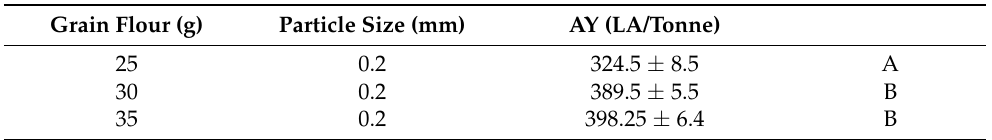
Table 5. Average alcohol yield achieved during experiments to test if there was a significant difference between using 25–35 g of grain flour. All results are the mean ± standard deviation ( n = 3). Different letters indicate a significant